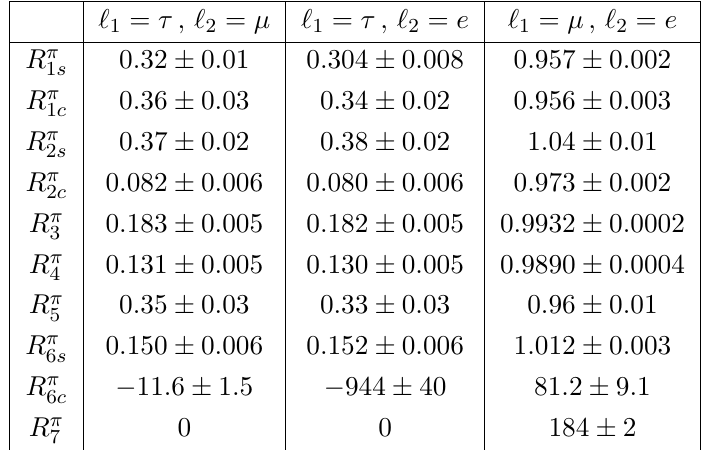
Table 3 . Ratios (6.15) in the NP scenario with the tensor operator, using CLN and at the bench- mark point ~ (cid:15) ‘ T